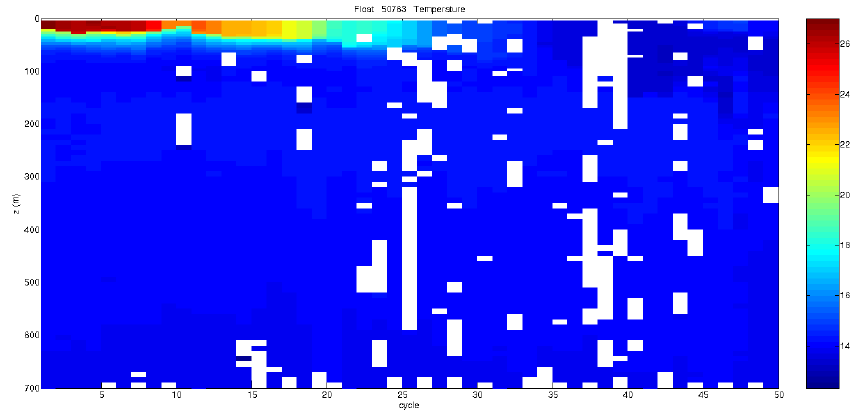
Fig. 1. Snapshot of a retrieved image showing the time evolution of the temperature vertical profiles between two user-specified cycles of surfacing. Mixing at the surface layer can be observed starting from cycle 20.